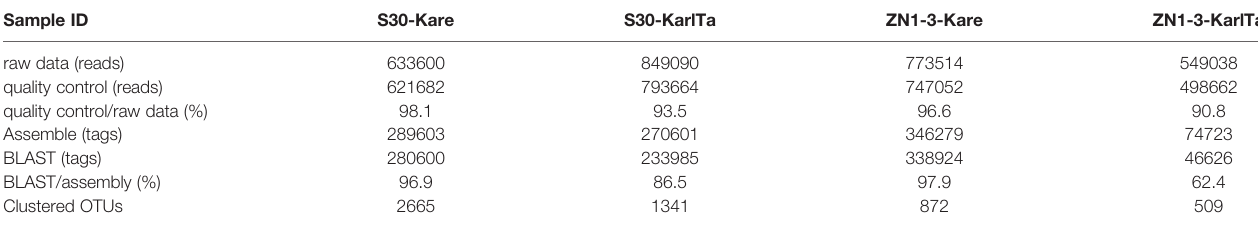
TABLE 7 | Quality control results of the Illumina sequencing data. Sample ID